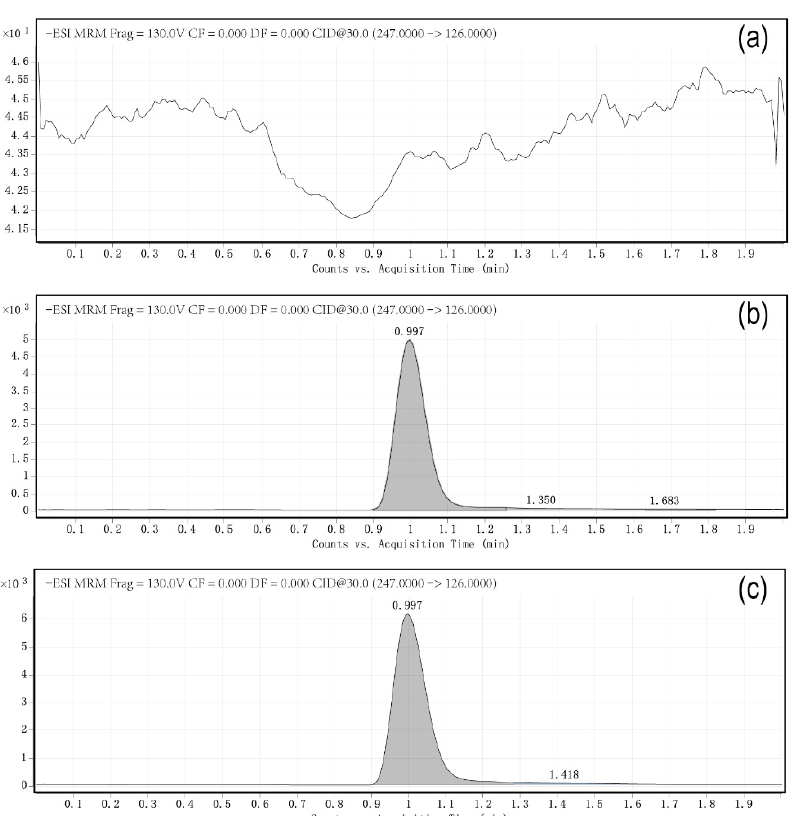
Figure 2. The liquid chromatography tandem mass spectrometry (LC-MS/MS) chromatogram of fludioxonil ( a ) sample of untreated cherries (0 mg/kg), ( b ) sample of fludioxonil standard in the cherry matrix (1.0 mg/kg), and ( c ) sample of cherries soaked in fludioxonil (4.93 mg/kg).